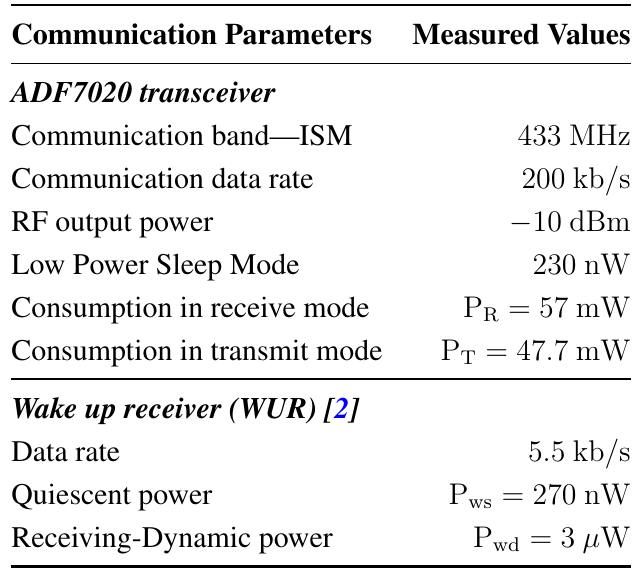
Table 1. ADF7020 and Wake Up Receiver